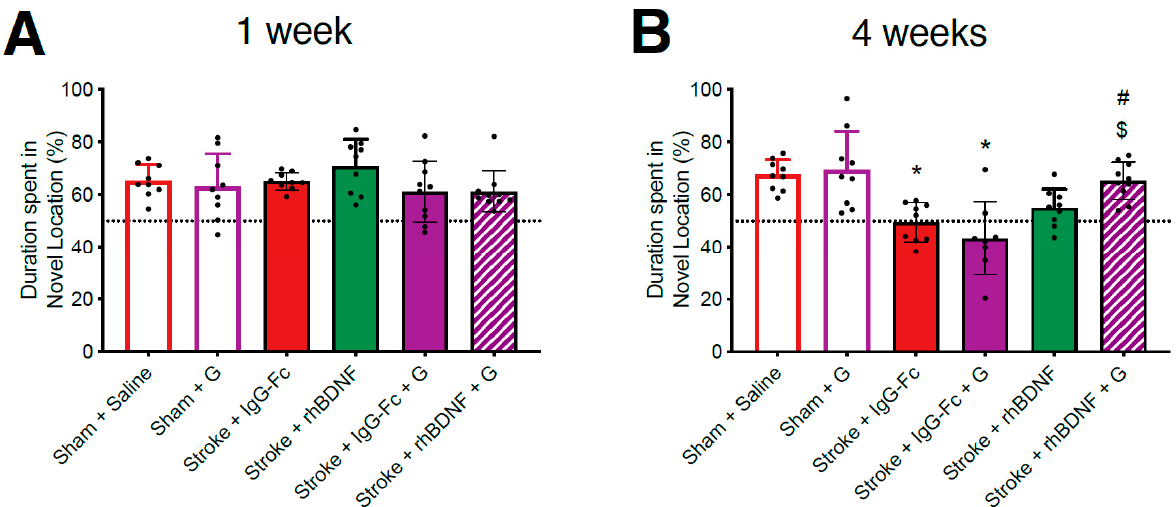
Figure 3. Effects of compound G treatment, with or without rhBDNF, on object location recognition task (OLRT) performance following PFC stroke. OLRT performance at one- ( A ) and four-weeks post-stroke ( B ) was compared between vehicle (sham + saline, n = 9; stroke + IgG-Fc, n = 9), compound G (sham: n = 9; stroke: n = 9), rhBDNF (stroke only, n = 9) or compound G + rhBDNF (stroke only, n = 9). At one-week post-stroke, all animals spent a similar percentage of the testing duration